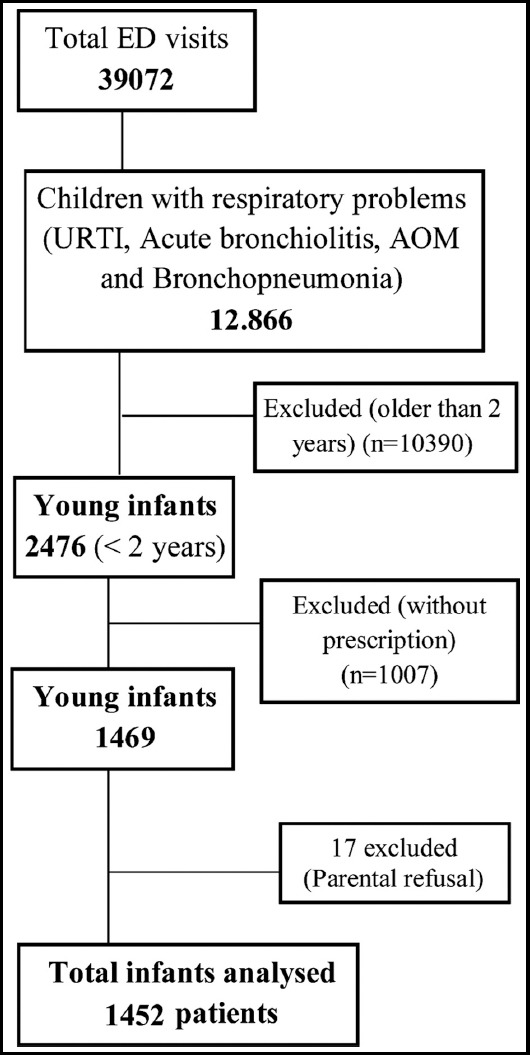
Flow chart of study enrollment.